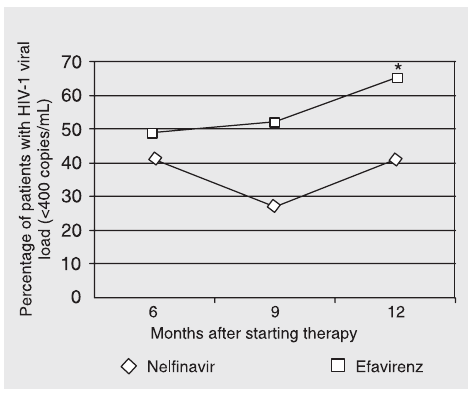
Figure 1. Percentage of patients with viral load <400 copies/mL according to regimen type. P < 0.01 at month 12 comparing efavirenz and nelfinavir (Yates- corrected test for categorical